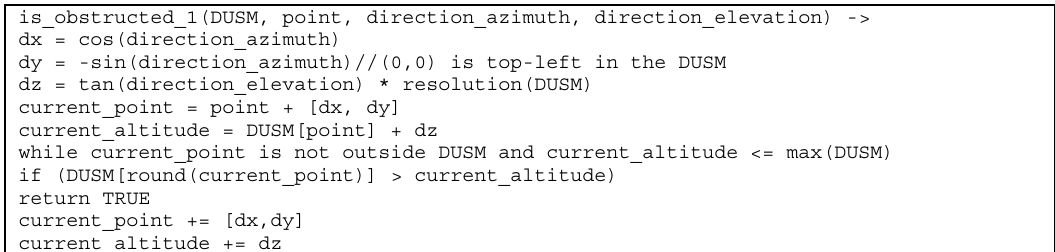
Figure 4. Concept of shadow casting algorithm adapted from [10]. In this example P 0 is shaded by P 1 , where the relative height ( H 1 ) is higher than the ray R , but not by P 2